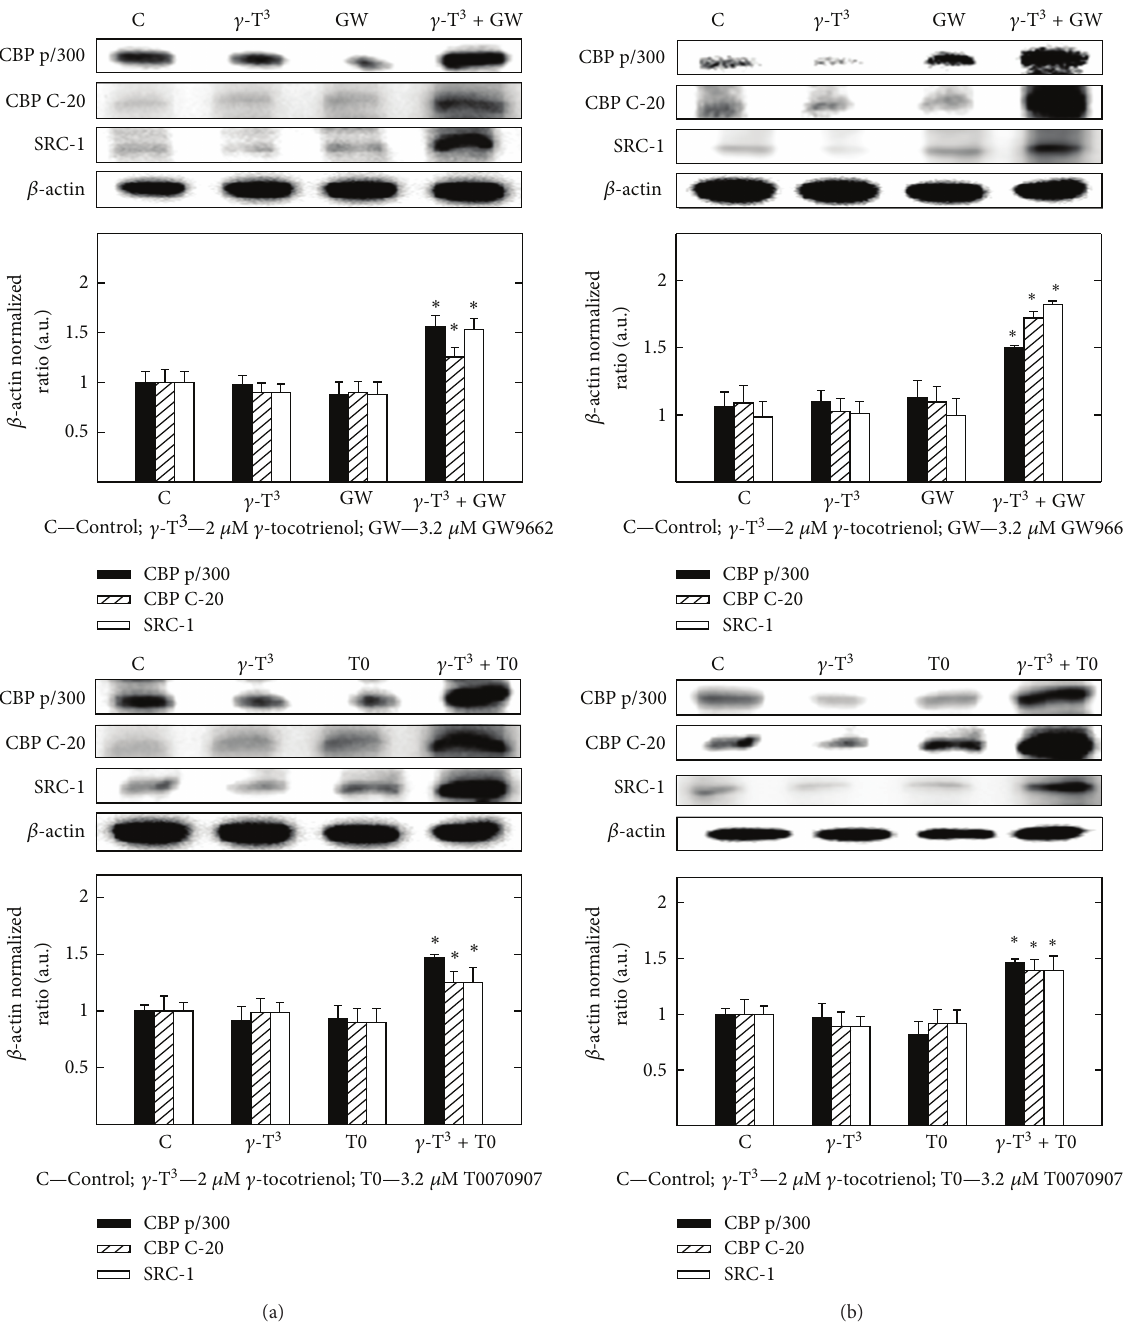
F 9: Western blot analysis of -tocotrienol and PPAR antagonists (GW9662 and T0070907) when used alone or in combination with each other to determine protein levels of CBP p/H300, CBP C-20, and SRC-1 in (a) MCF-7 and (b) MDA-MB-231 cells. MCF-7 cells were cells/100mm culture plate and treated with control or treatment media containing either 2 initially plated at 𝛾𝛾 𝛾𝛾 -tocotrienol, 6.4 M T0070907 alone or in combination. All cells were 1×10 treatment group for subsequent separation by polyacrylamide gel electrophoresis (50 g/lane) followed by Western blot analysis. Scanning densitometric analysis was performed on all blots done in triplicate and the integrated optical density of each band was normalized with corresponding -actin, as shown in bar graphs below their respective Western blot images. Vertical bars in the graph indicate the normalized 𝜇𝜇 as compared with vehicle-treated integrated optical density of bands visualized in each lane SEM. 𝛽𝛽 ∗ 𝑃𝑃 𝑃 0𝑃0𝑃 ±